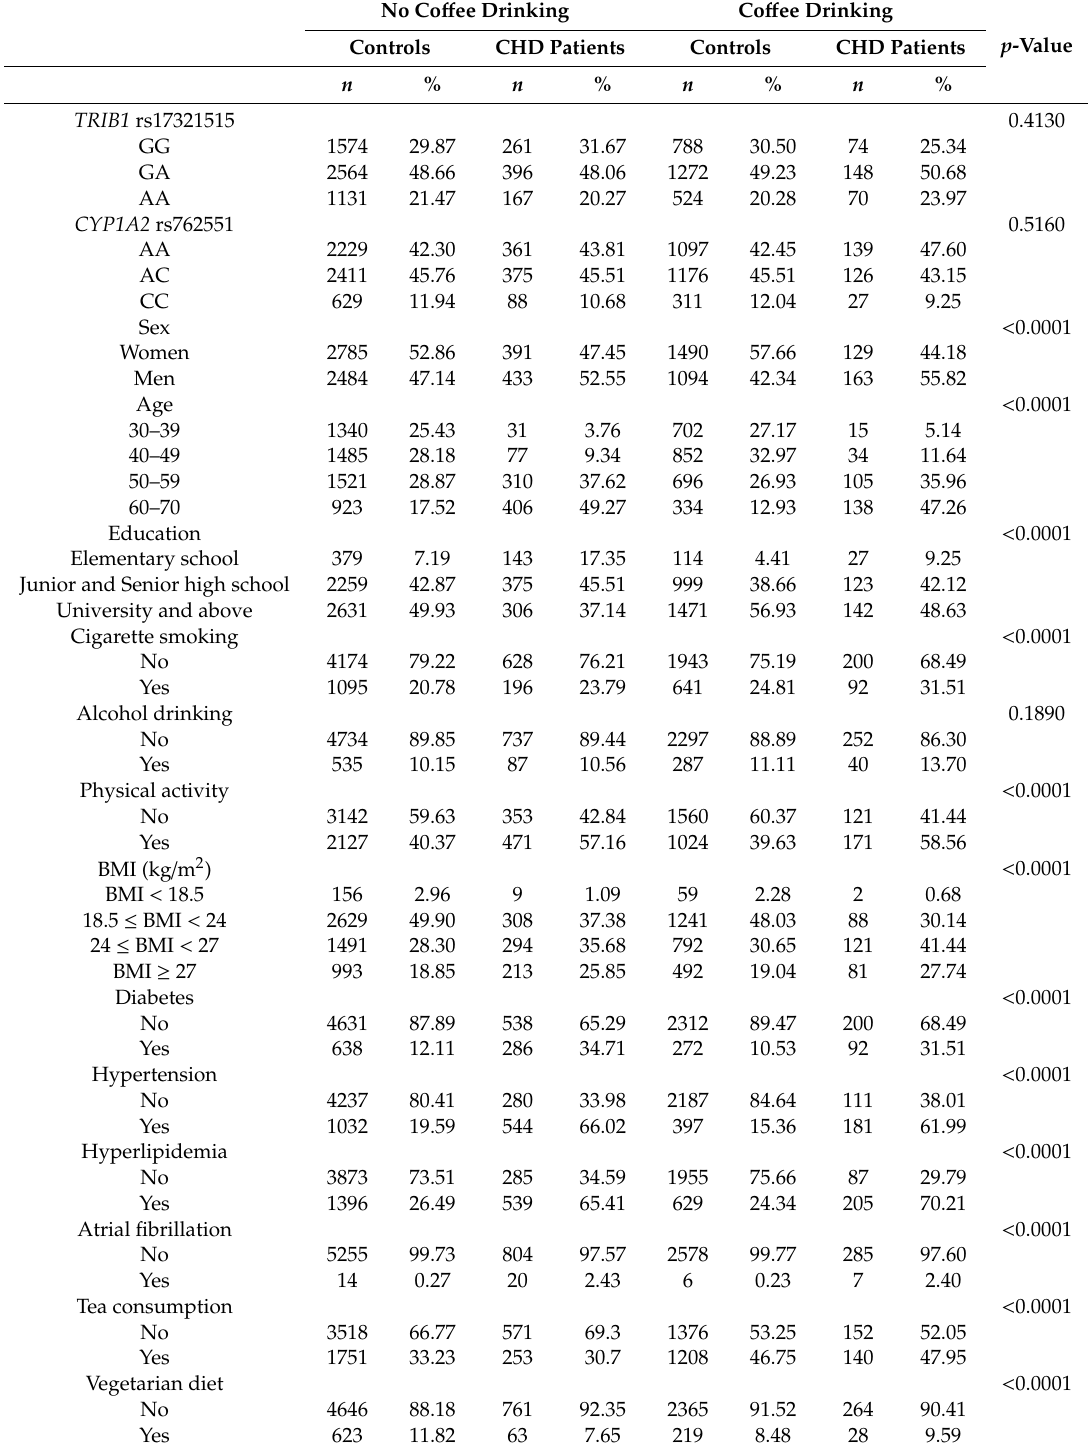
Table 2. Characteristics of study participants based on co ff ee